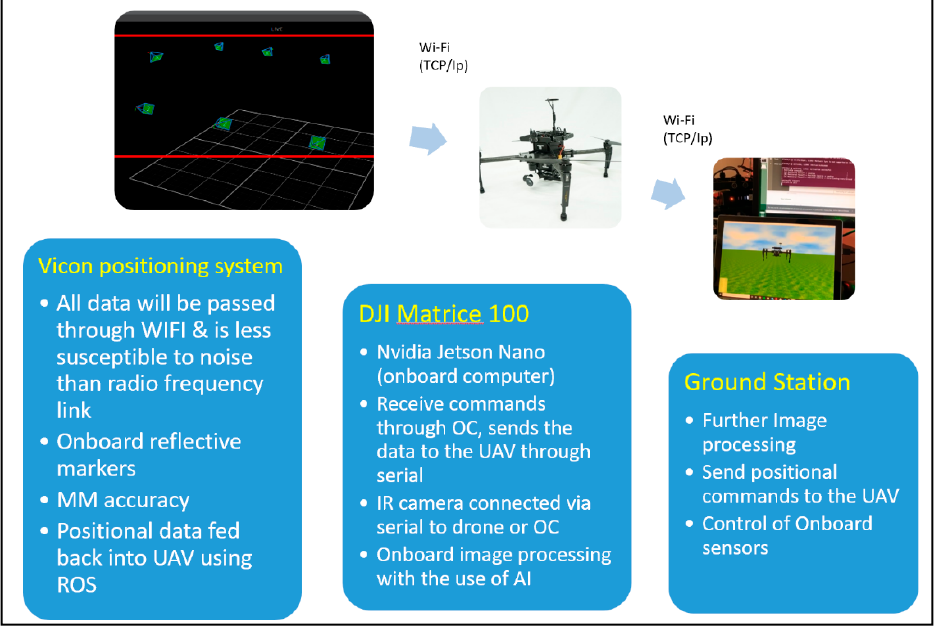
Figure 24. Flow chart of the indoor inspection process .